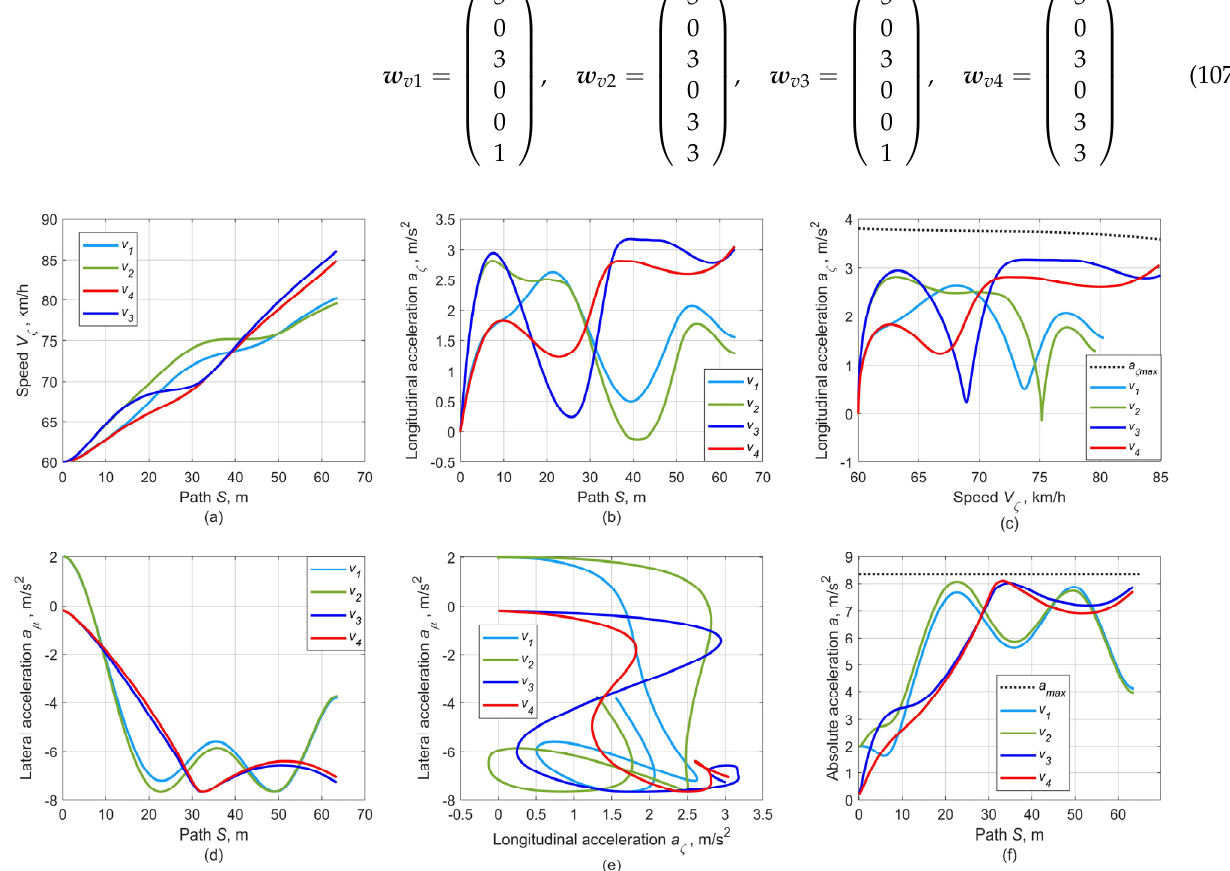
Figure 8. Results of the optimal plans for redistributing the kinematic parameters: ( a ) longitudinal speed along the trajectory, ( b ) longitudinal acceleration along the trajectory, ( c ) longitudinal acceleration along the longitudinal speed, ( d ) lateral acceleration along the trajectory, ( e ) relation between longitudinal and lateral accelerations, and ( f ) absolute acceleration along the trajectory.